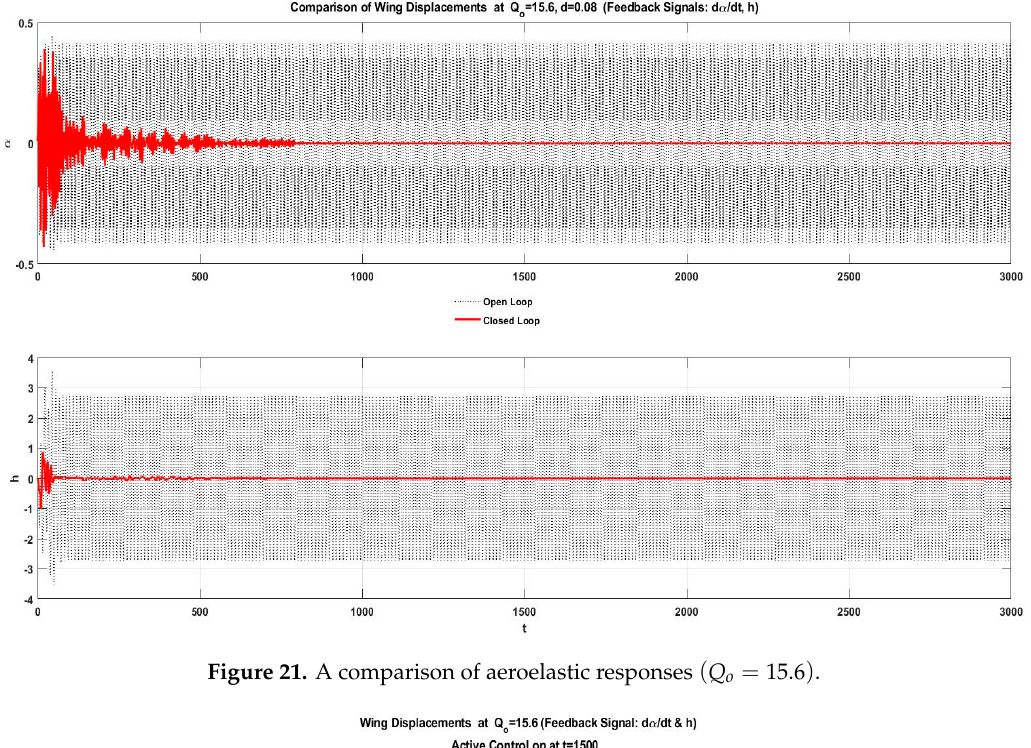
Figure 20. A comparison of aeroelastic responses (𝑄 (cid:3042) = 5) .